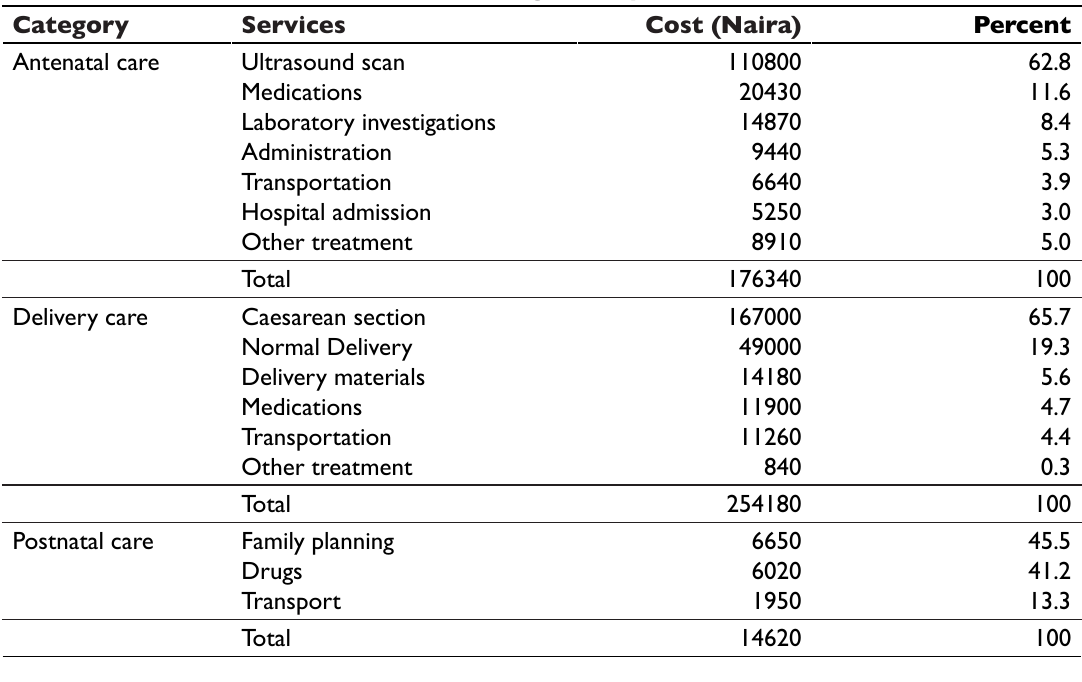
Cost of Maternal Healthcare among the respondents Category